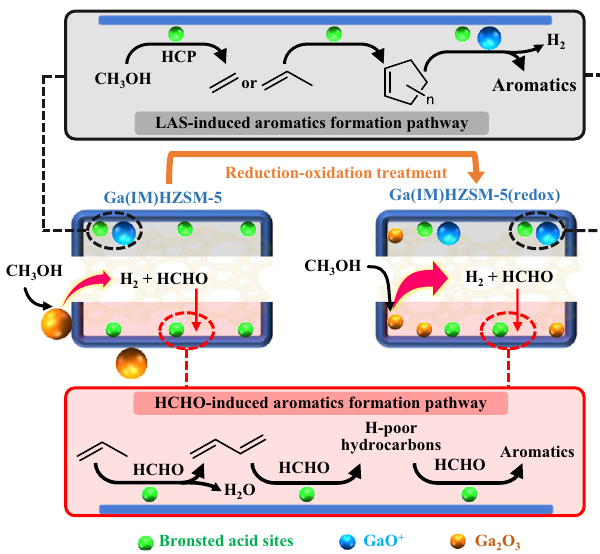
Fig. 5 Proposed evolution mechanisms of catalyst and aromatic formation. Mechanistic pathways for the formation of HCHO on Ga 2 O 3 , migration and transformation of Ga species upon reduction ‒ oxidation treatment, and the two kinds of aromatic formation